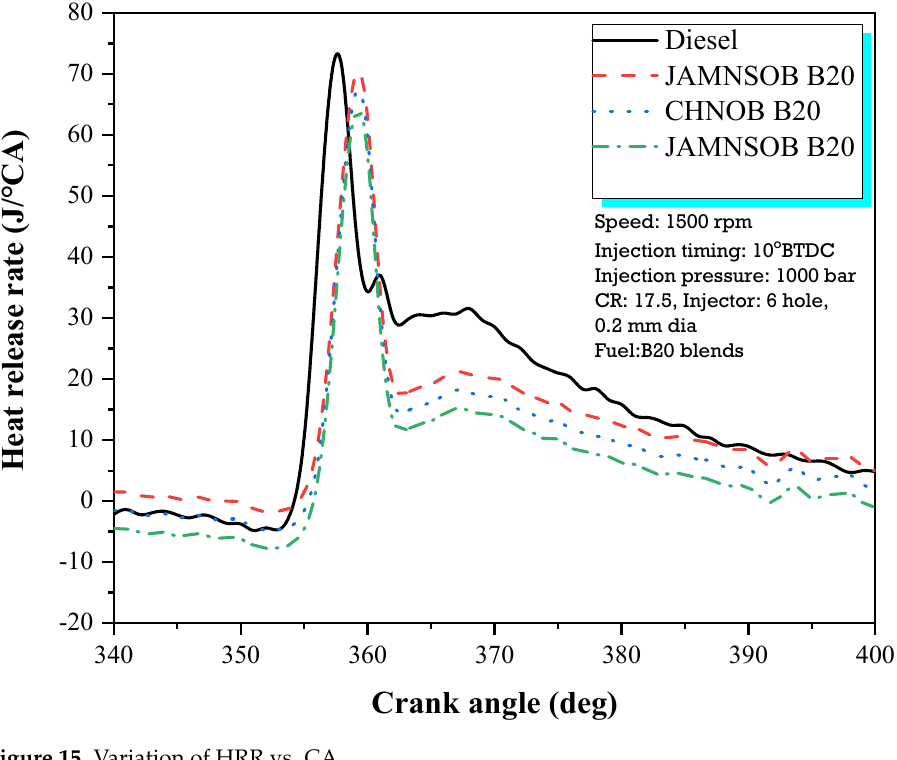
Figure 15. Variation of HRR vs. CA.